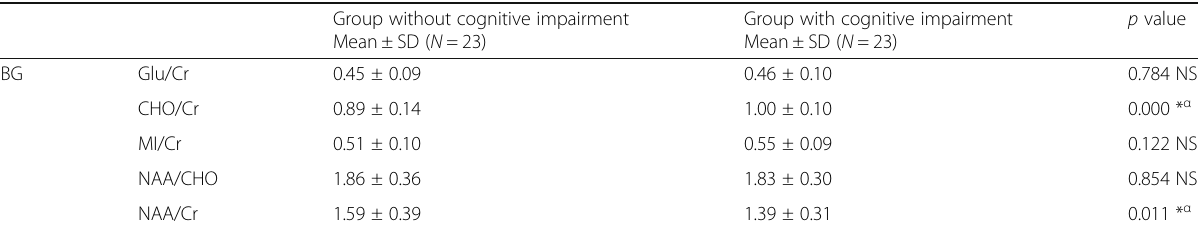
Table 2 Basal ganglia metabolites ratios in both groups